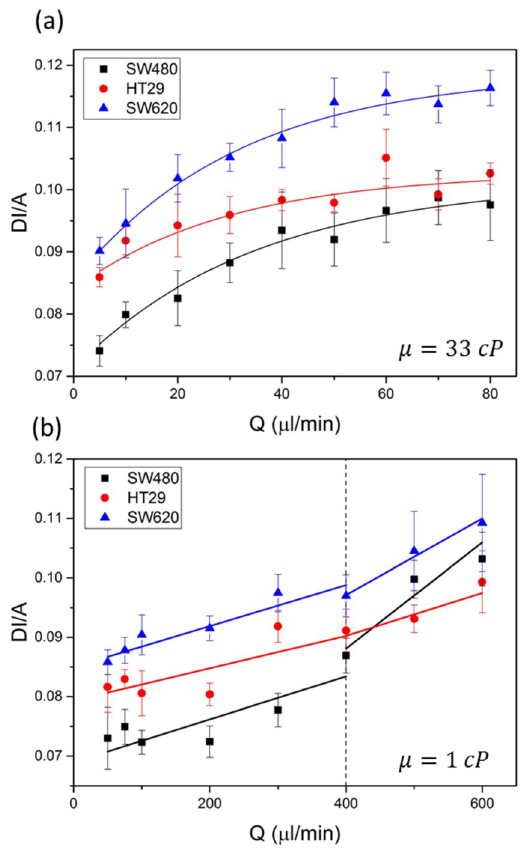
Figure 2. Size normalized deformation index ( DI/A) for three colorectal cancer cell lines over a range of flow rates ( µ l/min). DI A / was averaged from datasets from 3 separate experiments combined. ( a ) The flow